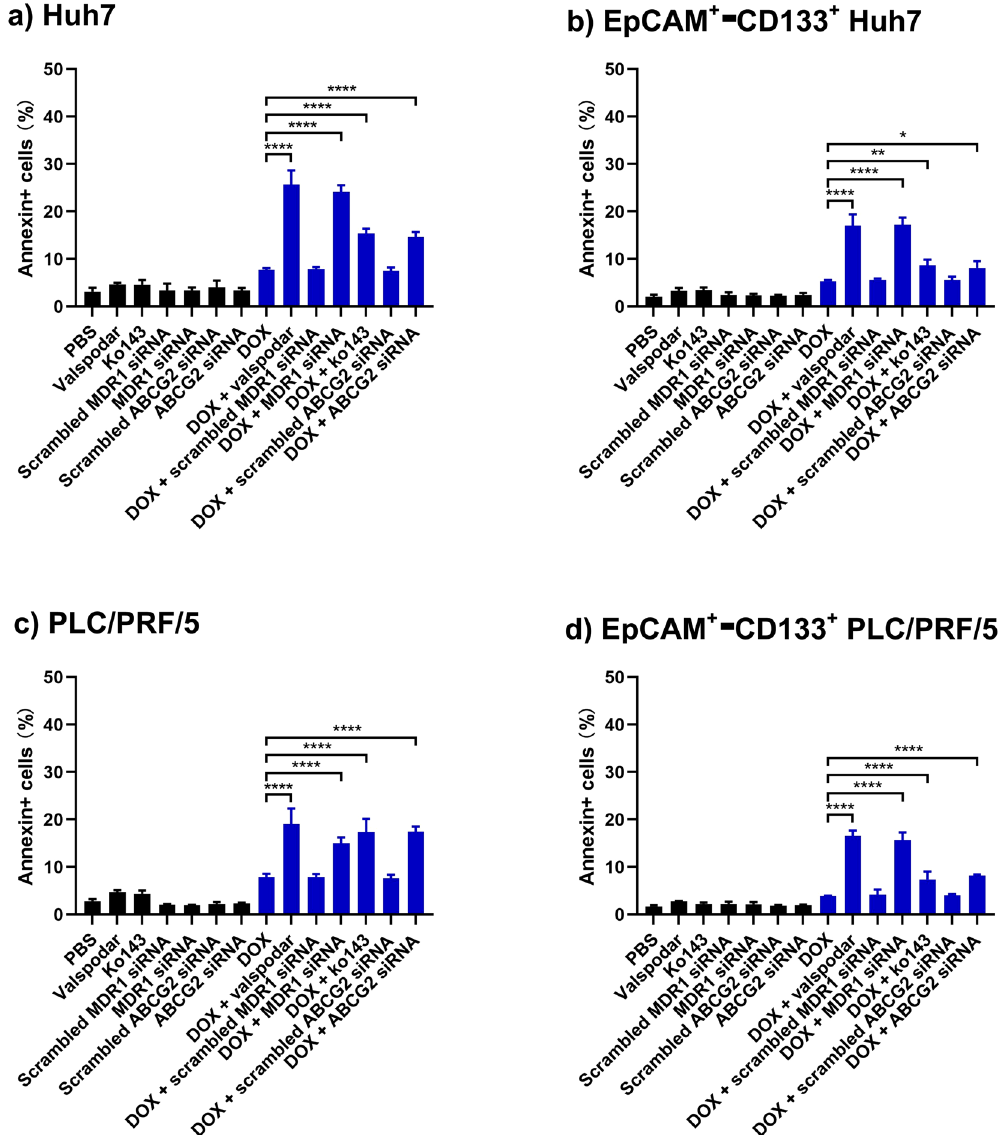
Figure 5. The effect of inhibition of MDR1 and ABCG2 on DOX-induced apoptosis. The cells were treated with 1 µM of MDR1 inhibitor valspodar or 1 µM of ABCG2 inhibitor ko143, and doxorubicin (DOX) (200 nM for Huh7 and 100 nM for PLC/PRF/5 cells, respectively) for 24 h. Alternatively, the cells were treated with 20 nM siRNA to MDR1 or ABCG2 for 6 h, followed by a further 42 h culture in the fresh culture medium. Then the Huh7 cells or PLC/PRF/5 cells were treated with 200 nM or 100 nM of DOX for 24 h. The total percentage of apoptotic cells as defined by the combination of 7-AAD − /Annexin V + and 7-AAD + /Annexin V + cells are shown for ( a ) bulk Huh7 cells, ( b ) bulk PLC/PRF/5 cells, ( c ) EpCAM + –CD133 + Hun7 cells as well as ( d ) EpCAM + -CD133 + PLC/PRF/5 cells. Data shown are mean ± SD, n = 3. **** p < 0.0001; *** p < 0.001; ** p < 0.01; * p < 0.05; compared with DOX-only